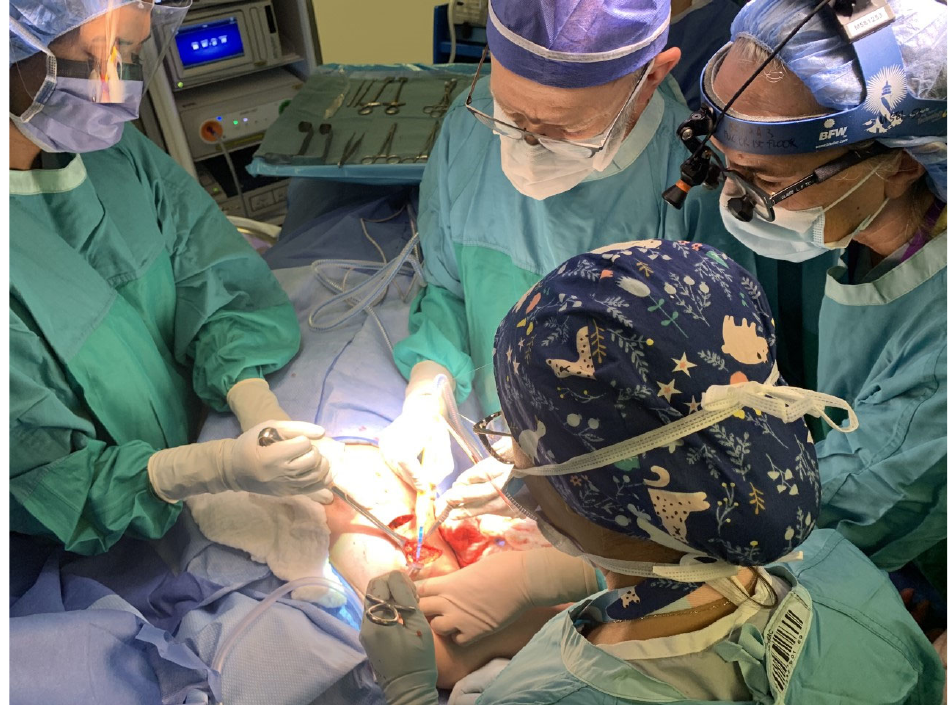
Figure 1. The team set up at an immediate lymphatic reconstruction in Calgary.